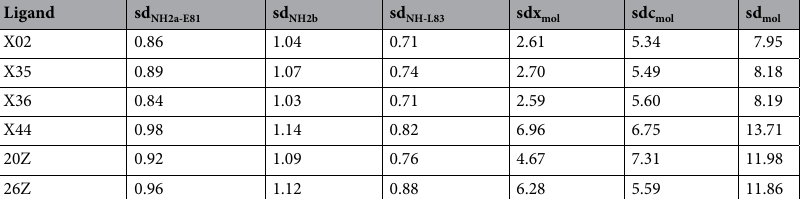
Table 2. Atomic and molecular strengths calculated using Jazzy against the active conformations of the selected inhibitors: sd NH2a-E81 and sd NH2b refer to the hydrogens of the primary amine, where NH2a-E81 interacts with the residue E81 and NH2b does not; sd NH-L83 refers to the hydrogen of the secondary amine; sdx mol is the sum of X–H donor strengths where X is any non-carbon atom; sdc mol is the sum of C–H donor strengths; sd mol is the sum of X–H donor and C–H donor